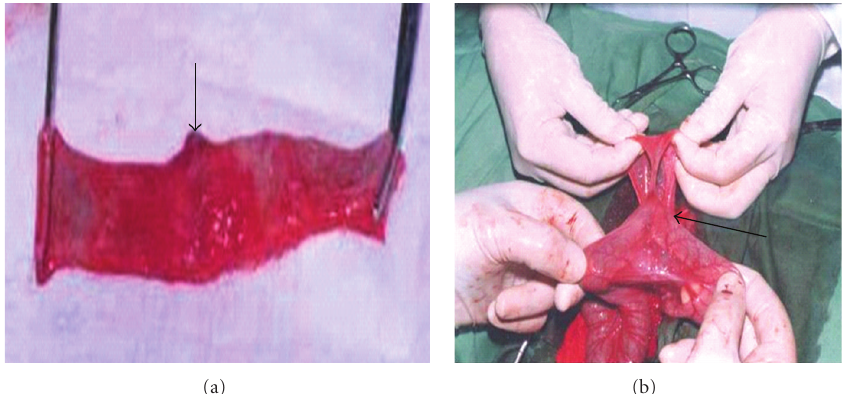
Figure 2: Photographs of experimental intestinal anastomosis in goat. (a) The anastomosis site (arrow) in the SSIS group on 21st POD. (b) Adhesion between intestinal anastomosis site and omentum (arrow) in horizontal mattress interrupted suturing (HMIS) group on 21st